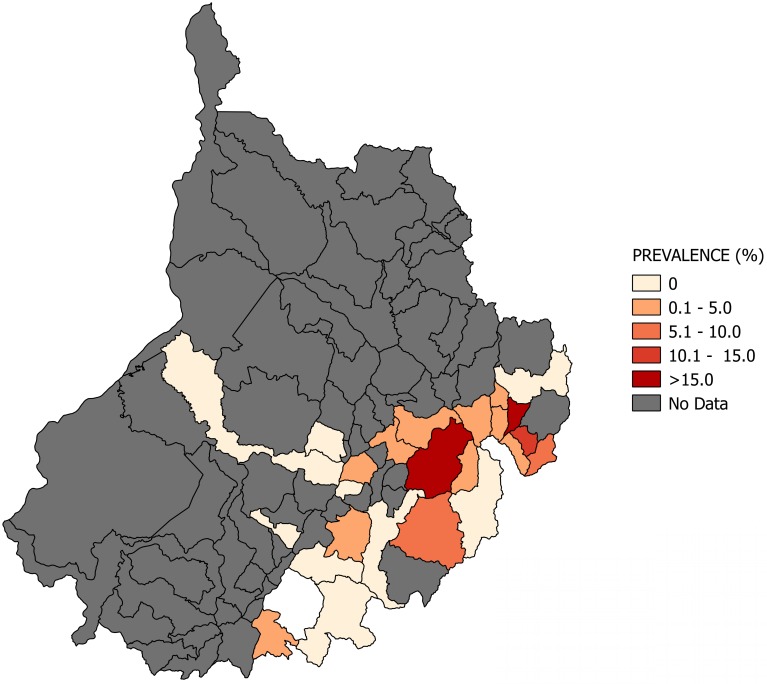
Map of the municipalities of Santander showing the distribution of observed Chagas disease prevalence in studies published from 2007 to November 2017.